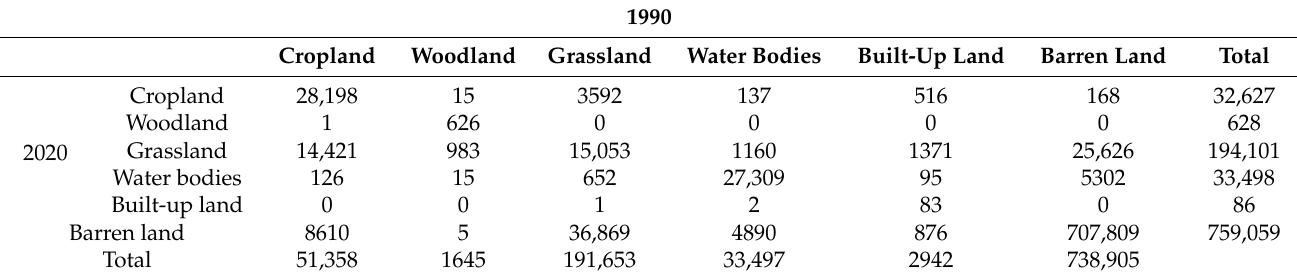
Table 3. Land Type Transfer Matrix 1990–2020 (km 2